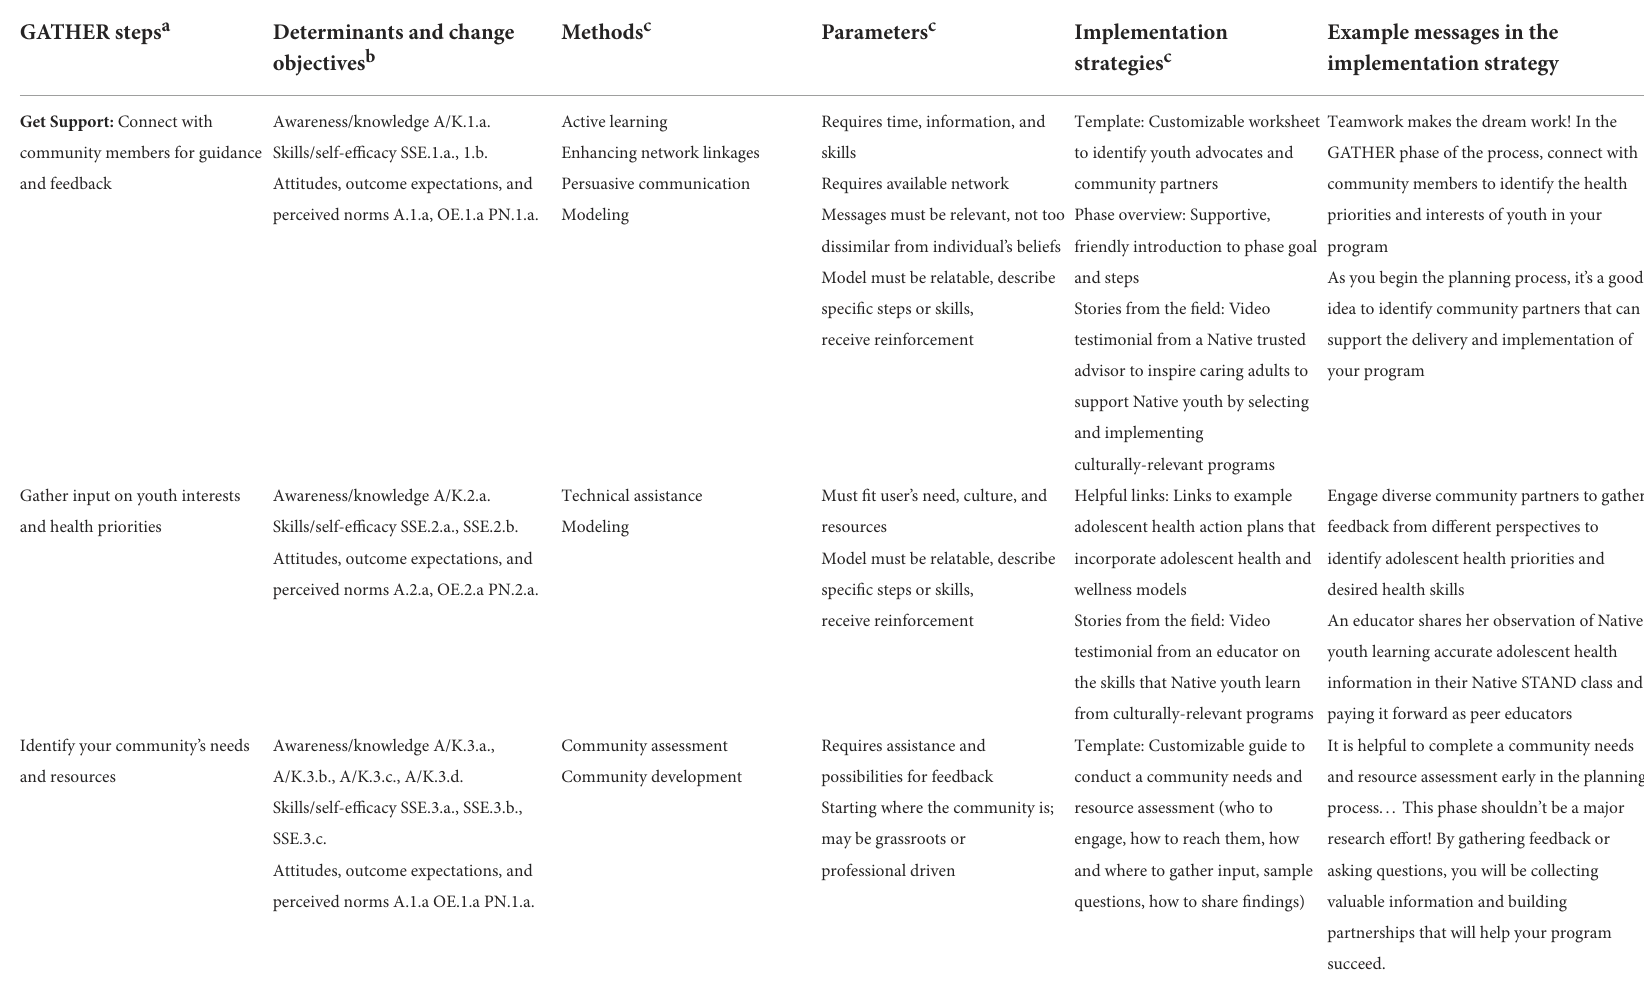
TABLE 4 Partial Implementation Mapping Tasks 3 and 4: Steps, determinants, methods, parameters, implementation strategies, and example messages from the Healthy Native Youth Implementation Toolbox GATHER